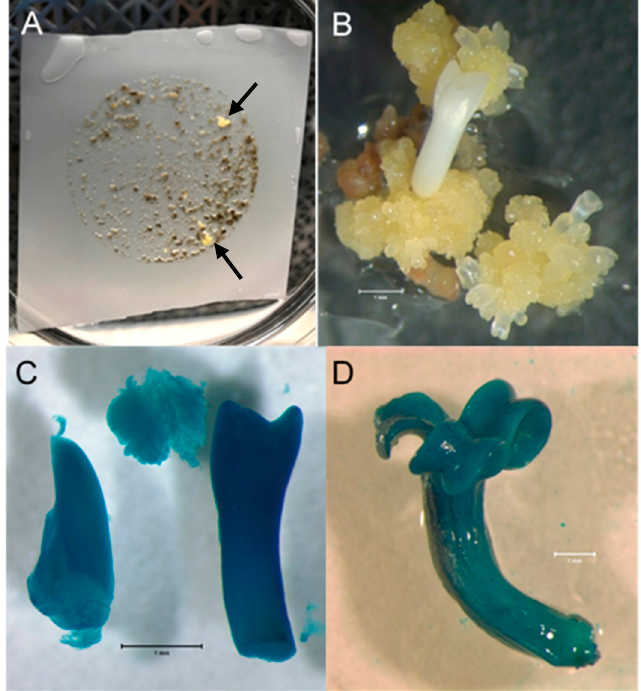
Figure 1. Ash embryogenic culture transformation. ( A ). Ash PEMs on nylon mesh following Agrobacterium co-cultivation and approximately six weeks of geneticin selection on semisolid medium. Petri plate is 100 mm in diameter. The first geneticin-resistant transgenic events to grow are marked with arrows. ( B ). A geneticin-resistant white ash colony continuing proliferation, with somatic embryos developing, 6 weeks after being picked from the nylon mesh and moved directly onto selection medium. Bar = 1 mm. ( C ). Transgenic white ash somatic embryos and callus displaying GUS expression following staining with X-gluc. Bar = 1 mm. ( D ). Transgenic green ash somatic embryo displaying GUS expression following staining with X-gluc. Bar = 1 mm.